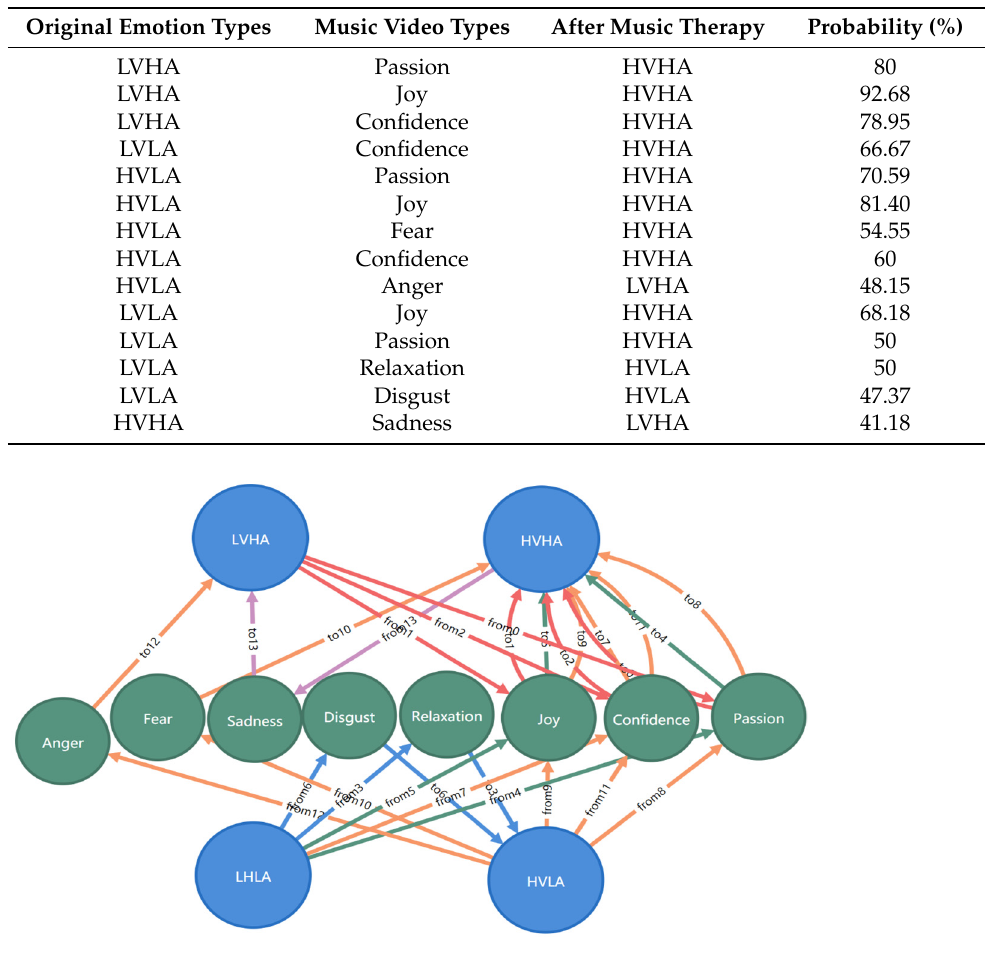
Figure 11. A graph for the relationship between music video types and emotion change in the va- lence arousal